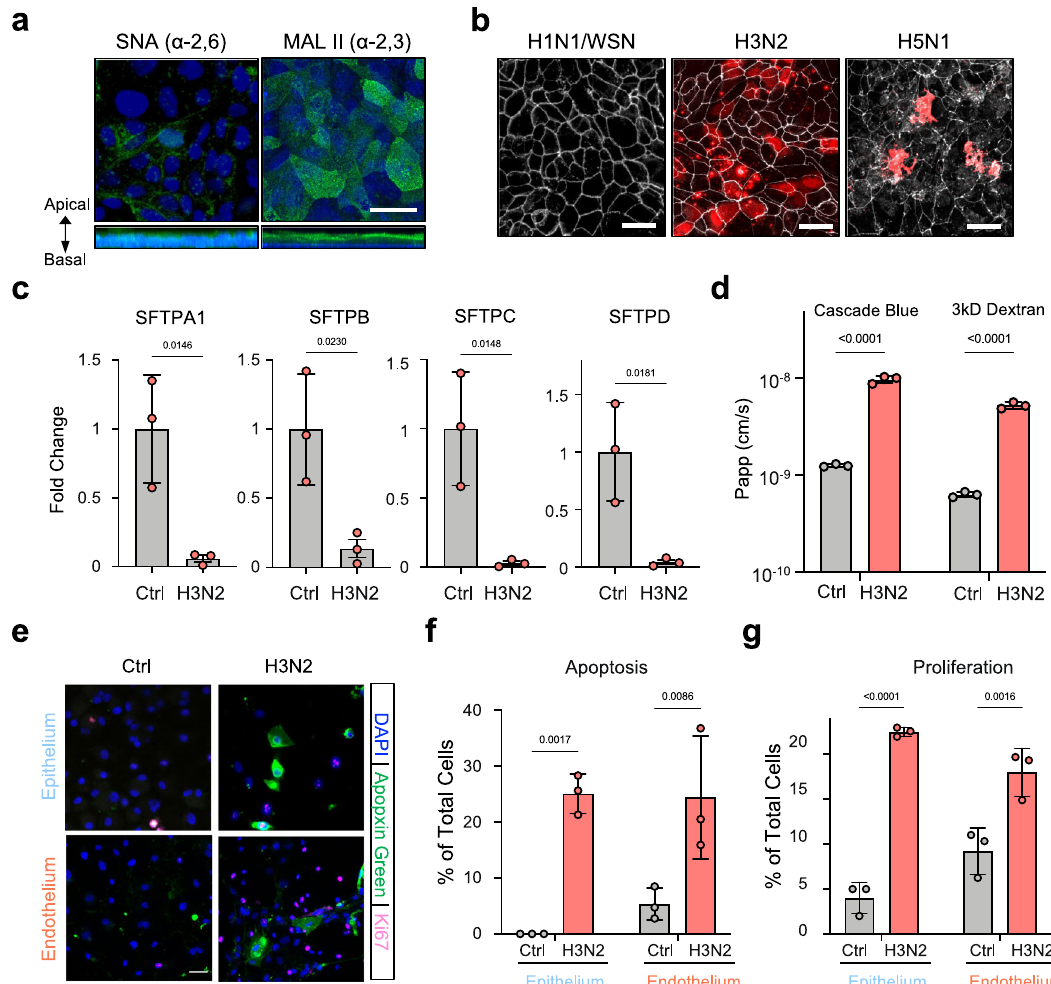
Fig. 2 Cellular phenotyping after in fl uenza A virus infection of the human alveolus chip. a Top and side fl uorescence views of the alveolar epithelium cultured on-chip and stained for α − 2,3-linked sialic acid or α − 2,6-linked sialic acid using Maackia Amurensis Lectin II (MAL II) and Sambucus nigra agglutinin (SNA), respectively (bar, 50 µ m). b Top fl uorescence views of the alveolar epithelium on-chip infected with three different in fl uenza virus strains (WSN (H1N1), HK/68 (H3N2), or HK/97 (H5N1) at MOI = 1) and stained for viral nuclear protein (NP) in red and ZO-1 in white. Scale bar, 50 µ m. c Graph showing decreased mRNA levels of surfactant genes by HK/68 (H3N2) virus infection at MOI = 1 compared with uninfected as control (Ctrl). d Graph showing increased lung permeability to cascade blue and 3 kD dextran by H3N2 infection on-chip. e Immuno fl uorescent images showing increased apoptosis as indicated by Apopxin Green staining and cell proliferation as indicated by Ki67 staining (bar, 50 µ m). f , g Graph showing quanti fi cations of cell apoptosis ( f ) and proliferation ( g ) at 24h after H3N2 infection on-chip. For c , d , f , g , data represent mean ± SD.; n = 3 biological chip replicates; unpaired two-tailed t -test. Source data are provided as a Source Data fi